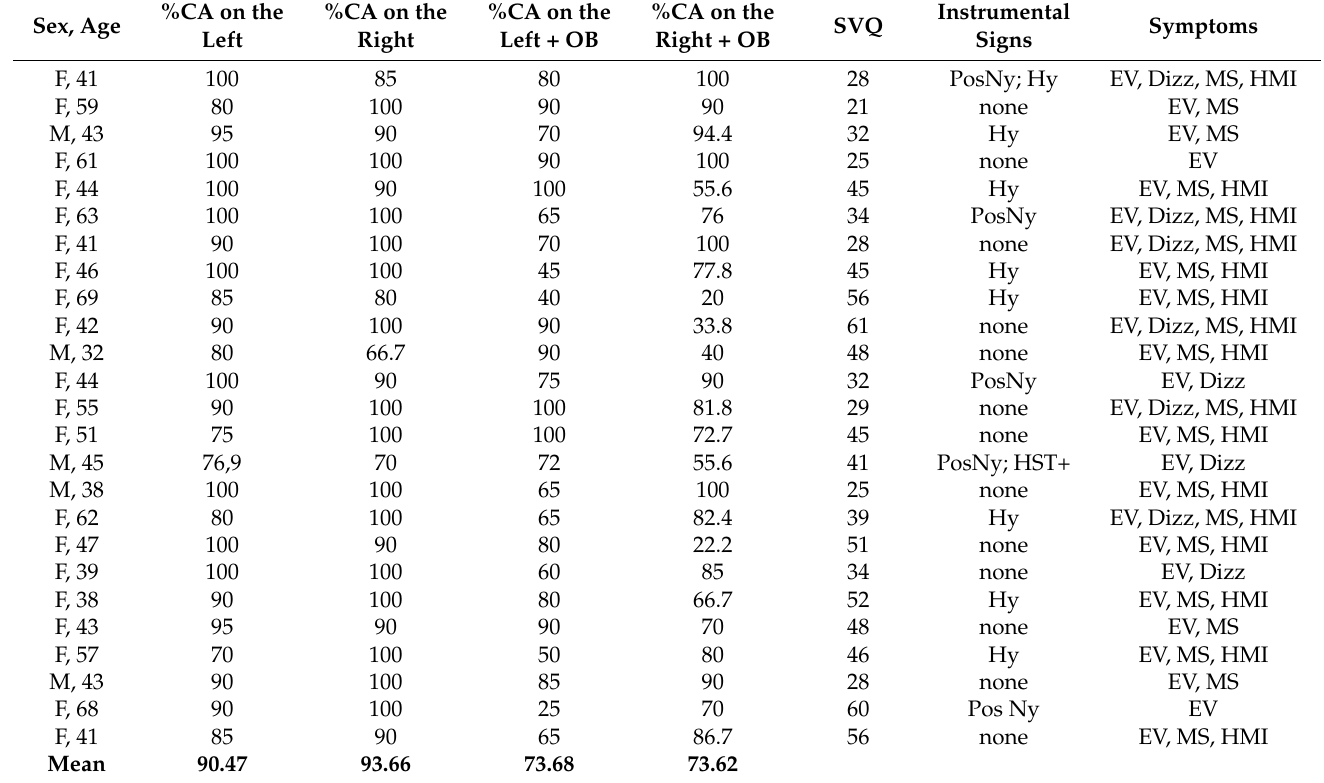
Table 2. The acute unilateral vestibulopathy group (AUV): demographic data, distribution of percentage of correct answers (%CA) on the left (L) and right (R) sides without and with the optokinetic background (OB), situational vertigo questionnaire (SVQ) score, and asymmetry index (AI) detectable via the vHIT.